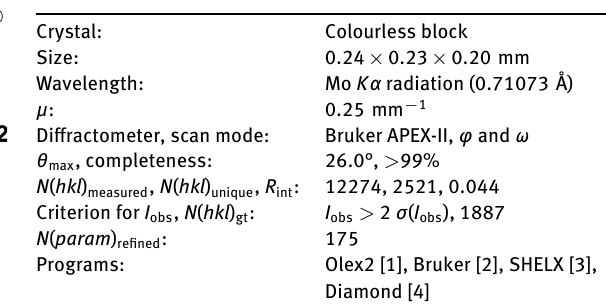
Table 1: Data collection and handling.